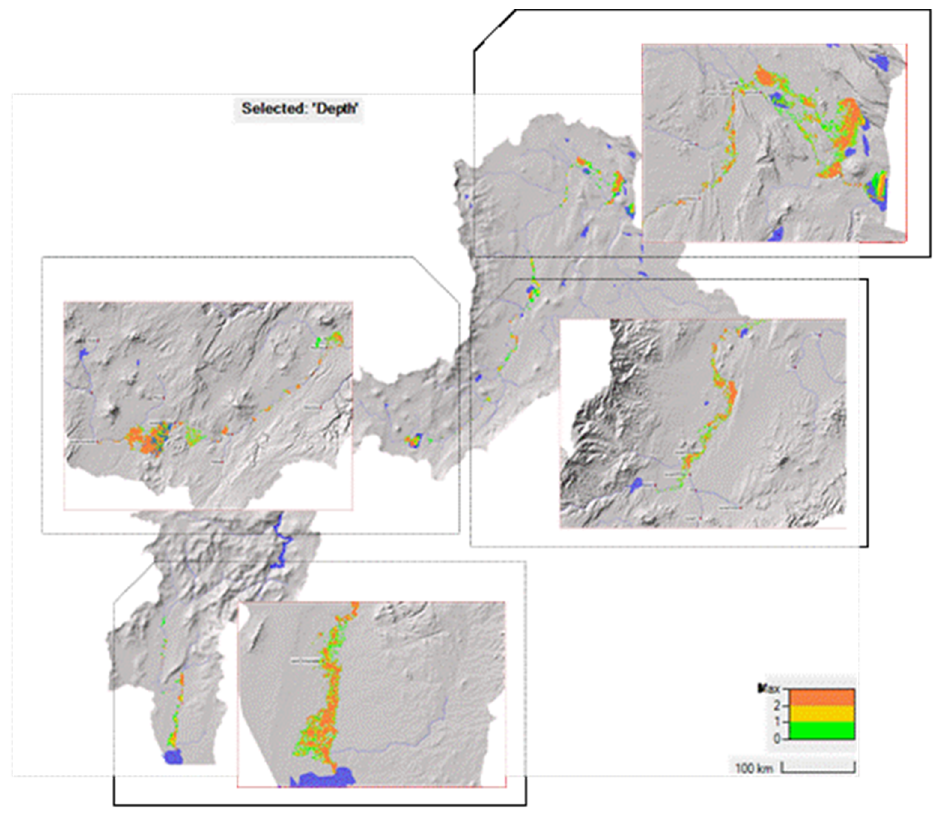
Figure 9. Flood inundation extents and flood depths from the model, August 2021.